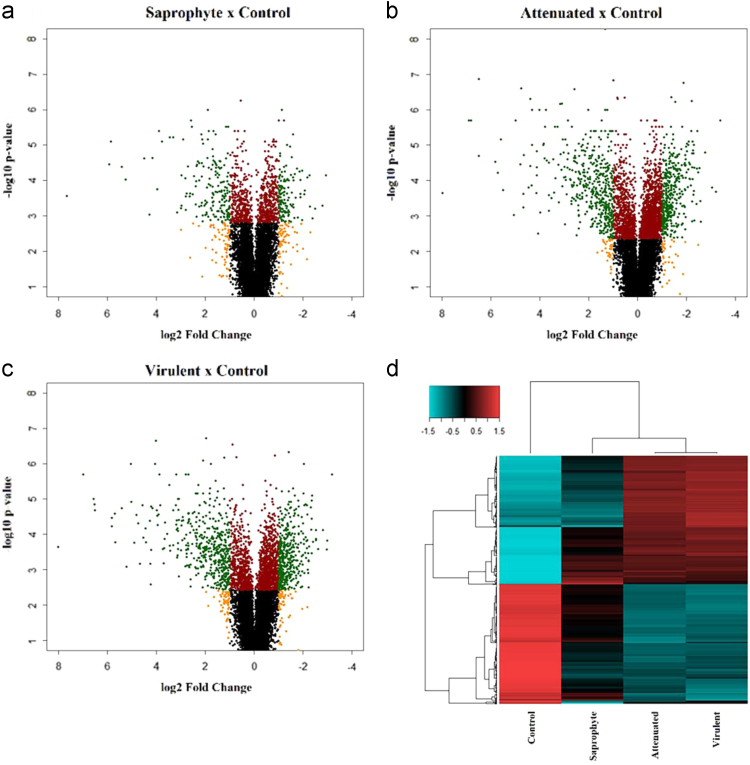
Distribution of differentially expressed genes. a-c) Volcano plot of microarray experiment for each treatment (saprophyte, attenuated and virulent) compared to control cells, containing 34.472 probes for murine macrophages. Red circles indicate probes with FDR < 0.05, orange circles are log2 fold change > 1 and green circles are the genes statically significant with both parameters, FDR < 0.05 and log2 fold change > 1. d) Heatmap of differentially expressed genes modulated by macrophages at 6 h of infection by different strains of Leptospira spp shows the average signal of genes. Upregulated genes are plotted in red color and downregulated genes in blue. (n = 3/treatment; p-value < 0.01; FDR < 0.05; linear fold change ± 2).